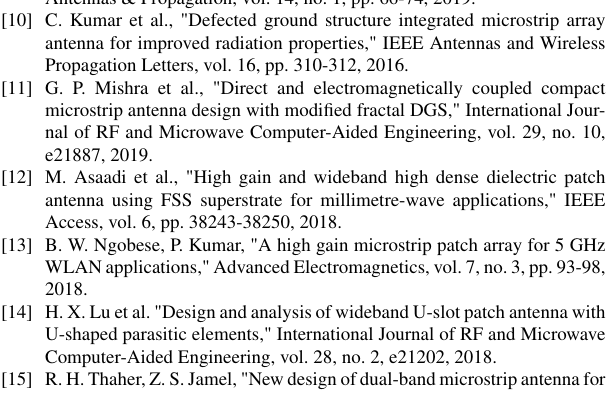
FIGURE 16. Simulated and measured reflection coefficient of the HGWMPA.